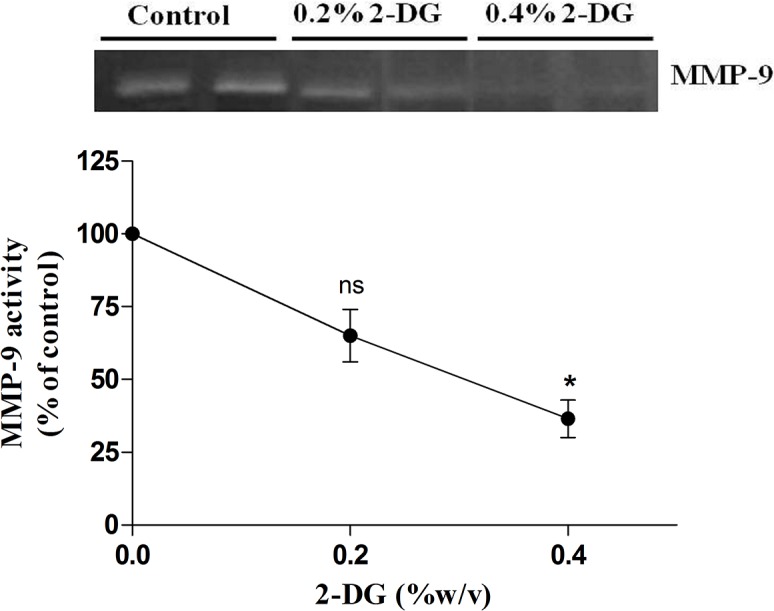
2-DG administration reduces MMP-9 activity.A dose dependent decrease was observed in the gelatinolytic activity of the EAC tumor tissue lysate from 2-DG fed mice in comparison to control mice. Scanning densitometry was used to quantify the MMP-9 gelatin hydrolysis (zymography) as shown in the graph. Data shown are representative of two independent experiments.